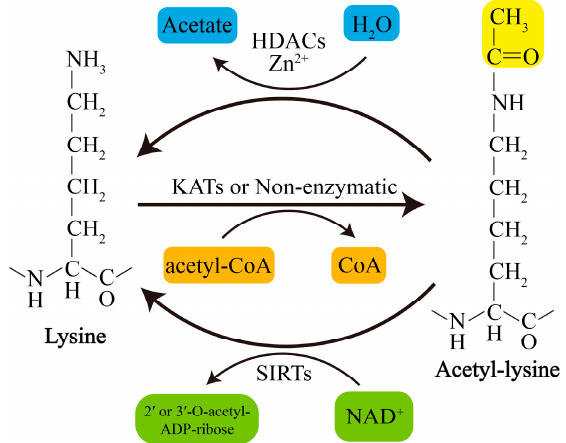
Figure 1. Schematic overview of lysine acetylation and deacetylation. Lysine acetylation, which is